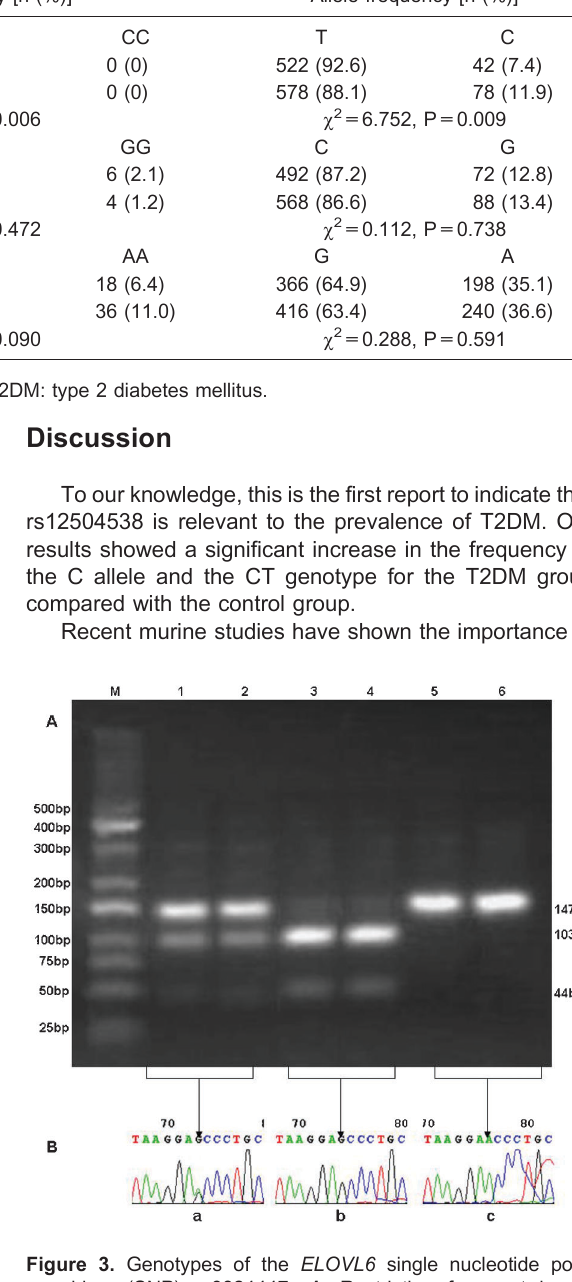
Table 3. Distribution of the ELOVL6 genotypes and alleles in T2DM patients and controls. SNP n Genotype frequency [n (%)]